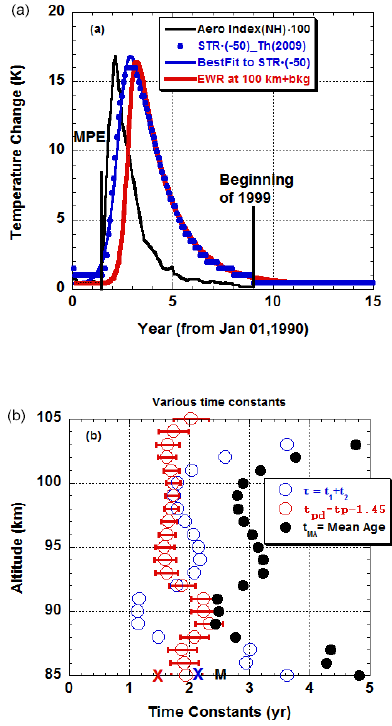
Figure 4. (a) A comparison between 100 · stratospheric aerosol (black) and the scaled global surface temperature response, STR · ( − 50), in blue dots, from Thompson et al. (2009), along with its best fit (blue curve) and episodic warming response (EWR) in temperatures at 100km (red curve). Both STR and EWR are over at the beginning of 1999, ∼ 7.5 years after the Mt Pinatubo eruption. (b) Deduced altitude-dependent time con- stant of the response, τ , peak delay time, t pd , and mean age, t MA , for the warming episodic function, respectively in open blue cir- cles, open red circles, and solid black circles. Marked at the bot- tom of the figure are the times for the surface temperature re- sponse, respectively by blue and red crosses and the letter M. Data, STR · ( − 50) in (a) is derived from http://www.atmos.colostate.edu/